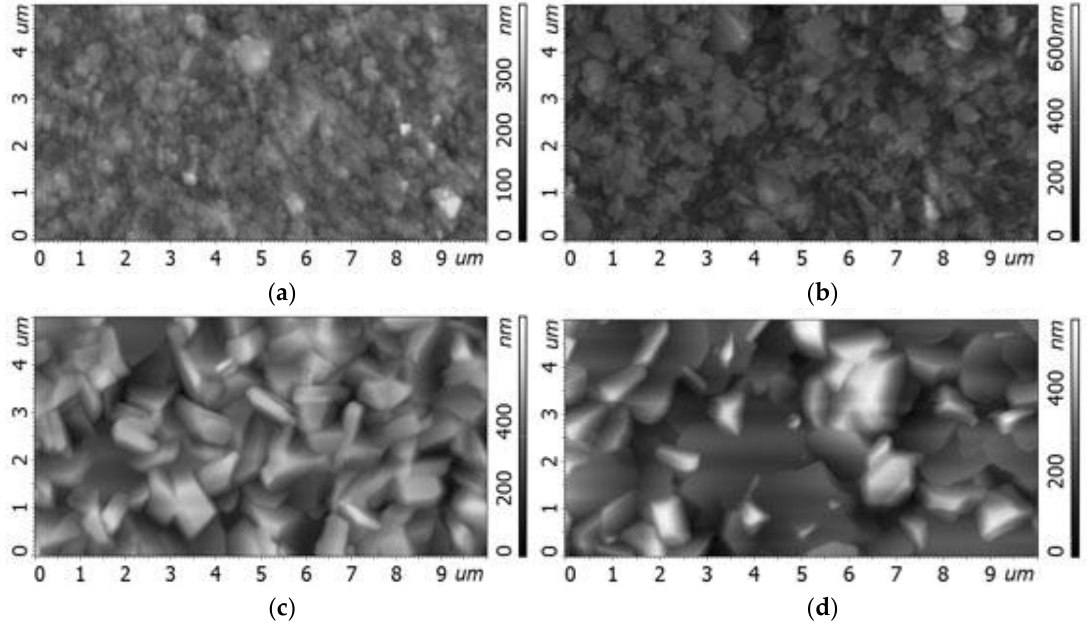
Figure 1. AFM images of SnS thin films at 200 °C ( a ), 250 °C ( b ), 300 °C ( c ) and 350 °C ( d ).